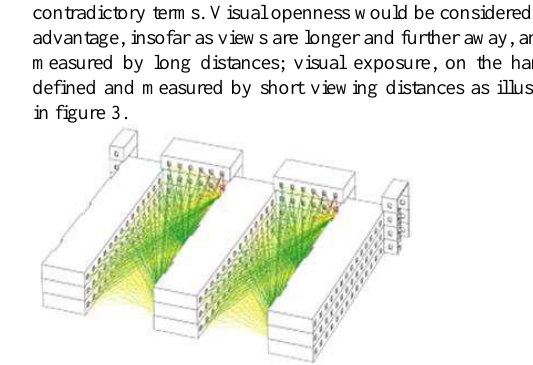
Figure 3: Visual Exposure As measured at Bat-Galim neighborhood, Length of view-lines for every window to other windows on every level (Shach-Pinsley et al., 2007, Fisher- Gewirtzman,